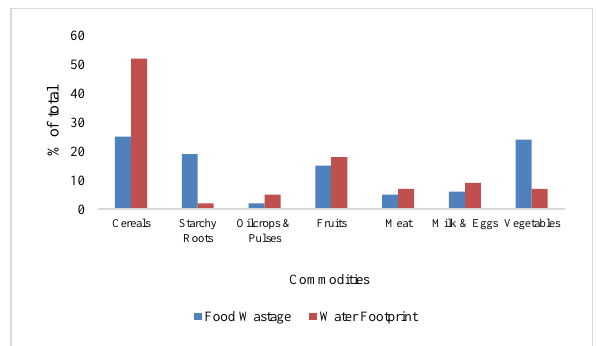
Figure 5: Water Footprint of Food wastage by Commodity (FAO,